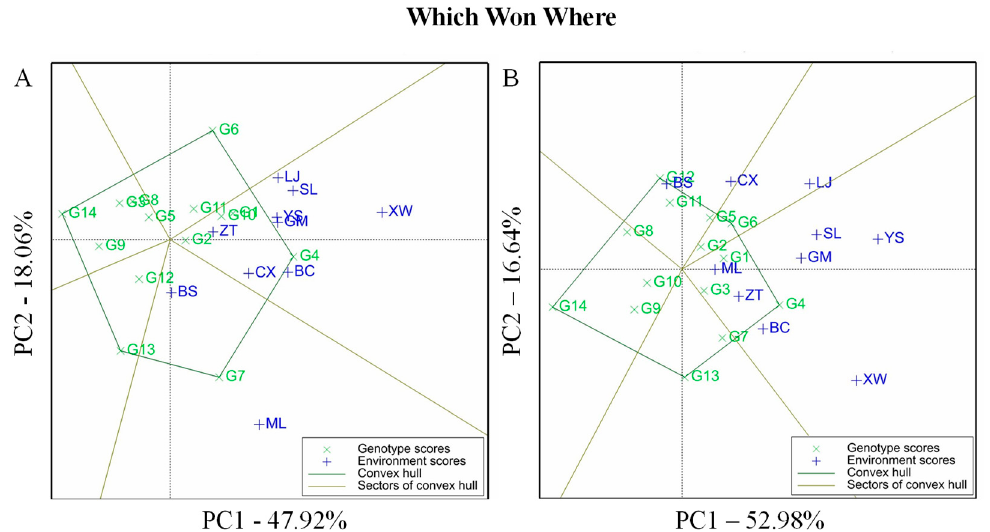
Figure 2. “Which-won-where” pattern of GGE biplot for 14 maize hybrids (G1-G14) evaluated across 10 environments. Genotypes at the vertices of the polygon are responsive to a particular environment: ( A ) GGE biplot in 2020; ( B ) GGE biplot in 2021. See genotype and environment codes in Tables 1 and 2, respectively.